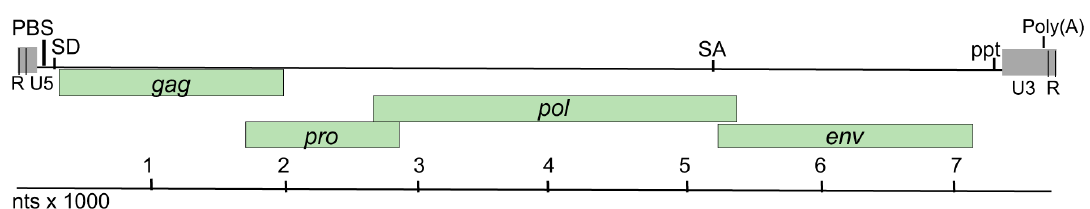
Figure 2. Gunnison’s prairie dog retrovirus genome organization. Diagram of the assembled GPDRV genome from tumors from prairie dogs 14-1342 and 15-1406. The Gag-Pro-Pol polyprotein is predicted to be translated from the genome by ribosomal frameshifting. Location of predicted sites-PBS-primer binding site, SD-splice donor, SA-splice acceptor, ppt-polypurine tract, poly(A)-polyadenylation sequence.